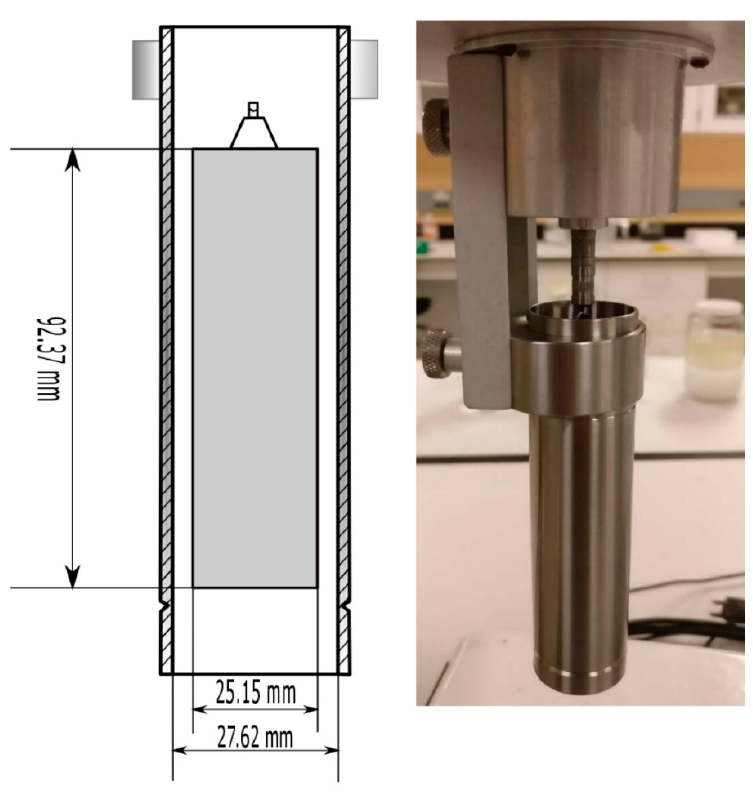
Figure 3. Schematic diagram of the enhanced UL adapter spindle assembly (left) and photograph of the enhanced UL adapter spindle assembly attached to the Brookfield LVT viscometer (right).